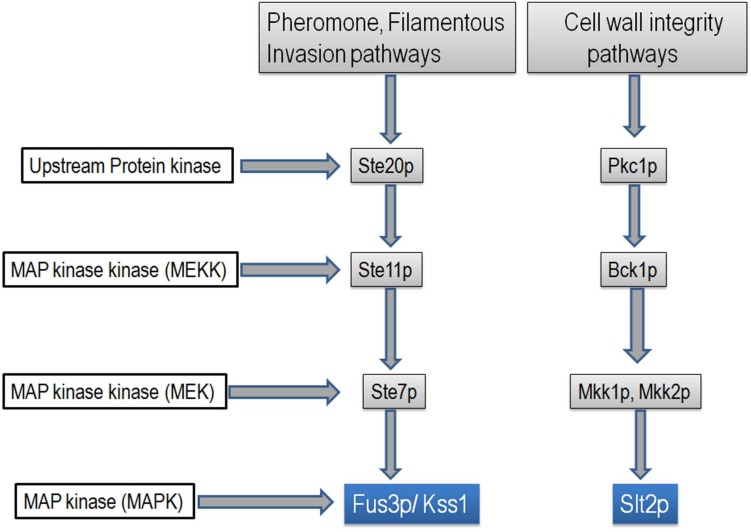
Schematic diagram showing pheromone, filamentous invasion, and cell-wall integrity pathways of the MAP kinase cascade of Saccharomyces cerevisiae. Diagram is adopted from (Errede et al., 1995; Gustin et al., 1998).